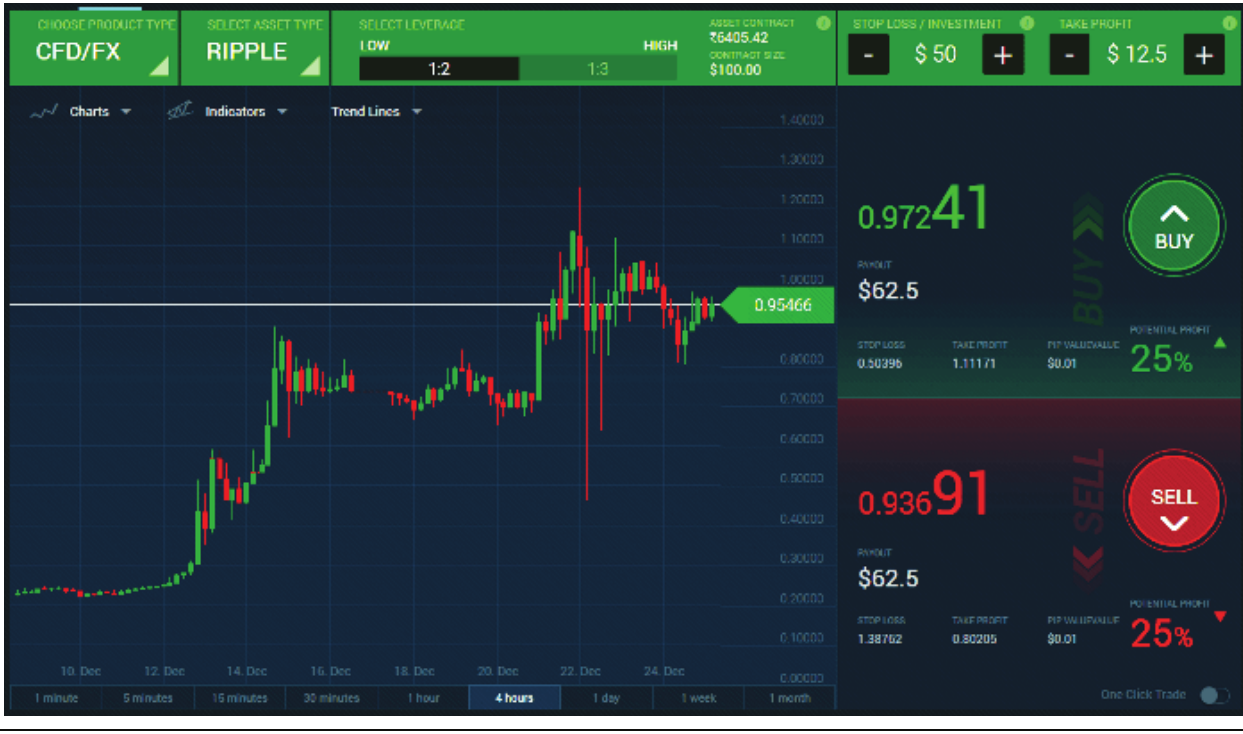
FIGURE 1: An online trading